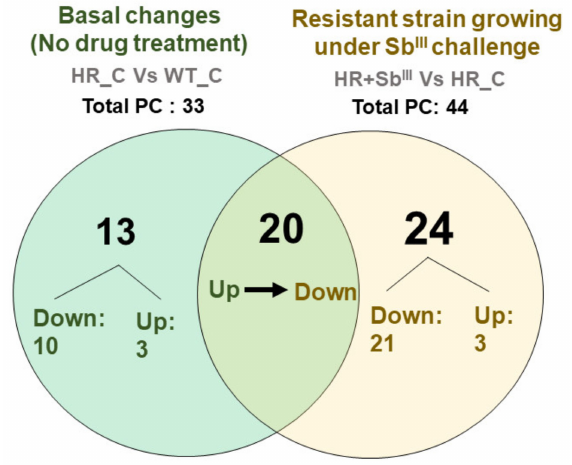
Figure 5. Phosphatidylcholine (PC) decrease is associated with the antimony resistant profile. The distribution of differentially expressed PCs is represented in a Venn diagram. Both the downregulated or upregulated PCs are plotted by two different comparisons: basal phenotypic changes in resistant strain in the absence of drug (green circle) and resistant strain responding to Sb III (yellow circle). Total values correspond to total PC detected as significantly differentially